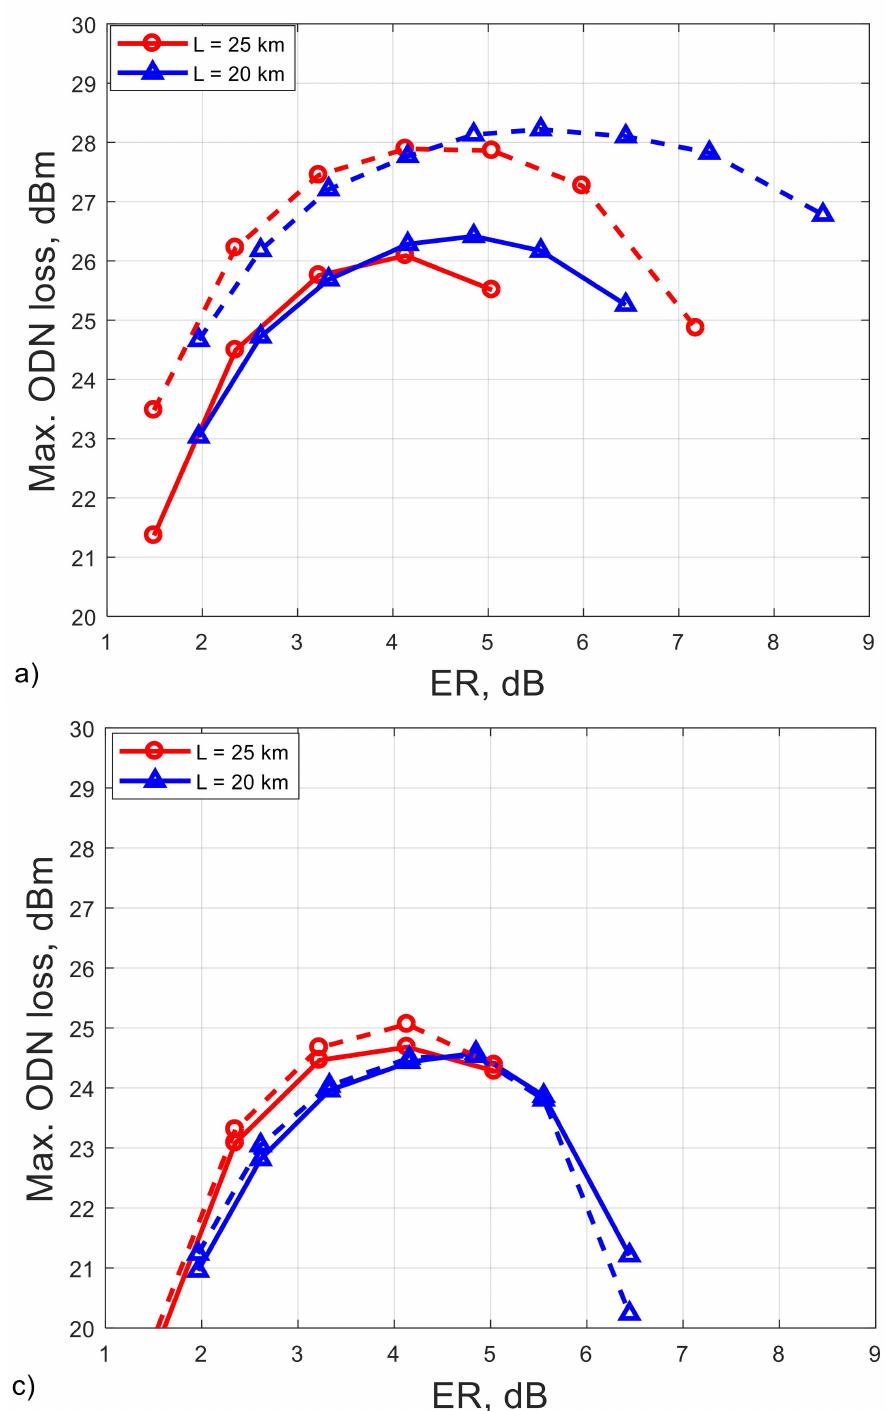
Figure 5. Maximum ODN loss as a function of ER over 20 km or 25 km SMF in C-band (1550 nm) and with bias current of the DML i b = 60 mA. Solid: FFE; dashed: FFE + DFE. ( a ) EDB, ( b ) PAM-2, and ( c )